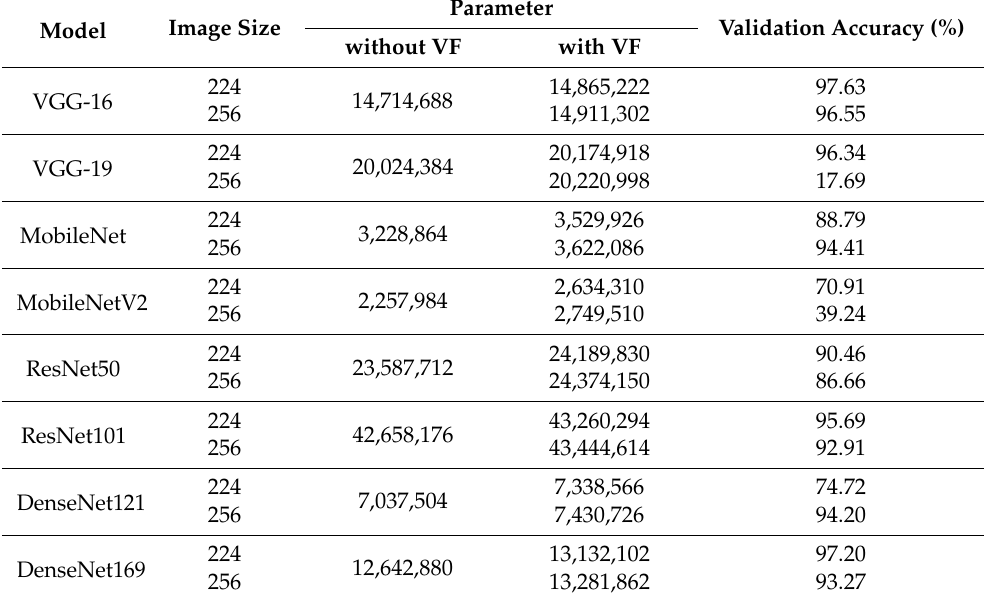
Table 3. Parameters of each pre-trained